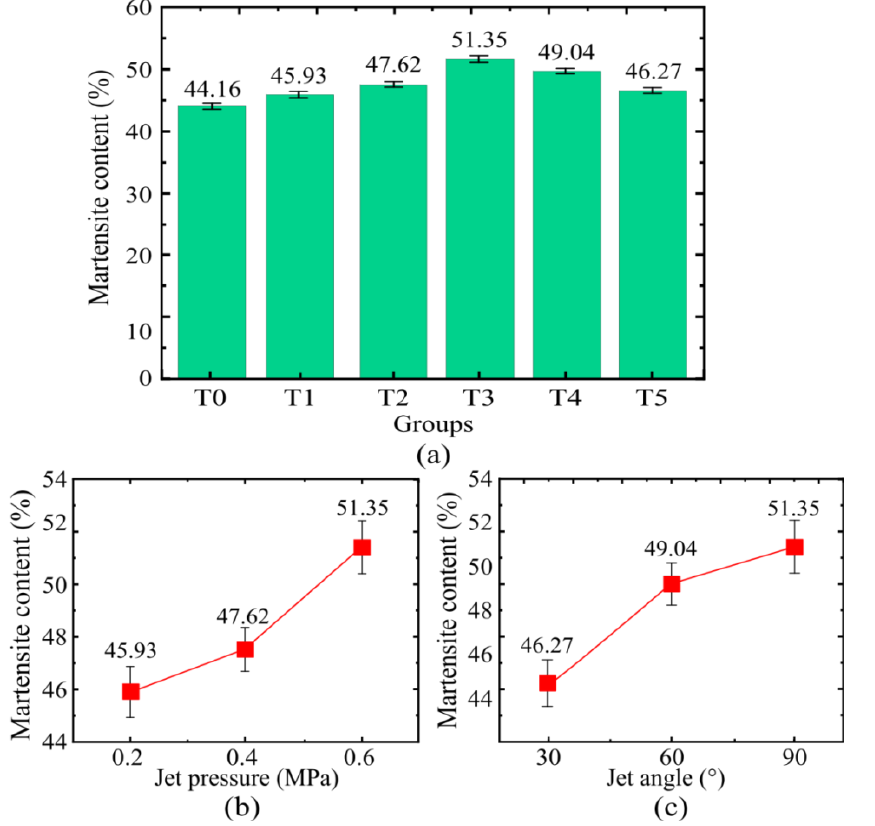
Figure 10. ( a ) Martensite and retained austenite content of processed surface; ( b ) Martensite content changes with jet pressure; ( c ) Martensite content changes with jet angle.